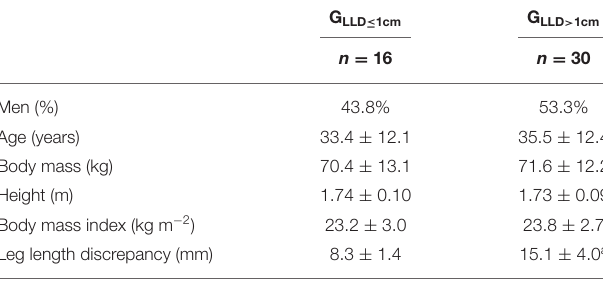
TABLE 1 | Sociodemographic, anthropometric characteristics, and pain ratings of the subjects included in each